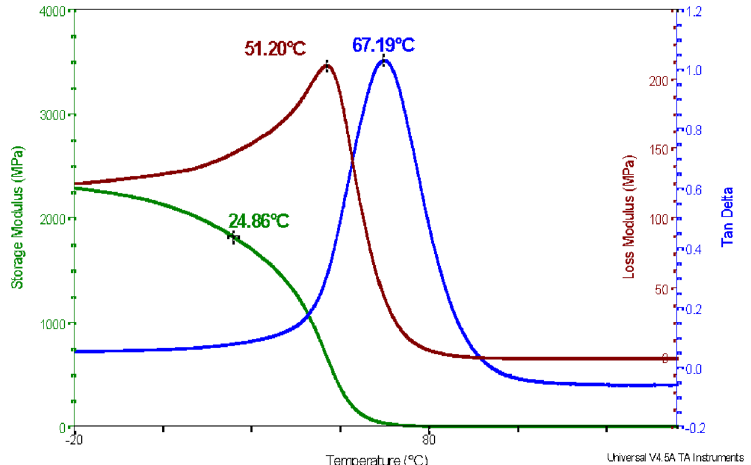
Figure 2. Thermal analysis curve of Polymer A obtained from single-frequency